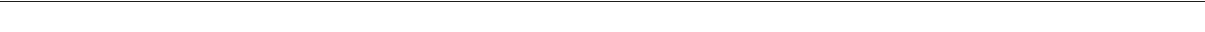
Fig. 5 CDYL represses SCN8A transcription through an intronic element. a , b Knockdown of CDYL increased SCN8A expression. Hippocampal DG tissues were obtained from mice ( a ) or rats ( b ) infected with lentiviruses containing CDYL-shRNA or nonsilencing-shRNA for 14 days. Western blotting was used for mice experiments ( a ). For rats ( b ), the mRNA and protein levels of SCN8A and CDYL were examined by real-time RT PCR ( left ) and western blot analysis ( middle ) and quanti fi ed ( right ). n = 3, * p < 0.05, paired two-tailed Student ’ s t -test. c SCN8A is downregulated in transgenic mice over-expressing CDYL. Hippocampus tissues were obtained from adult WT or CDYL-TG littermates. Western blot analysis and quanti fi cation were performed. n = 4,* p < 0.05, ** p < 0.01, paired two-tailed Student ’ s t -test. d Mouse hippocampus tissues were obtained from WT and CDYL-TG littermates. ChIP experiments were performed using the indicated antibodies. Real-time PCR assays were performed for the measurement. n = 3, * p < 0.05, paired